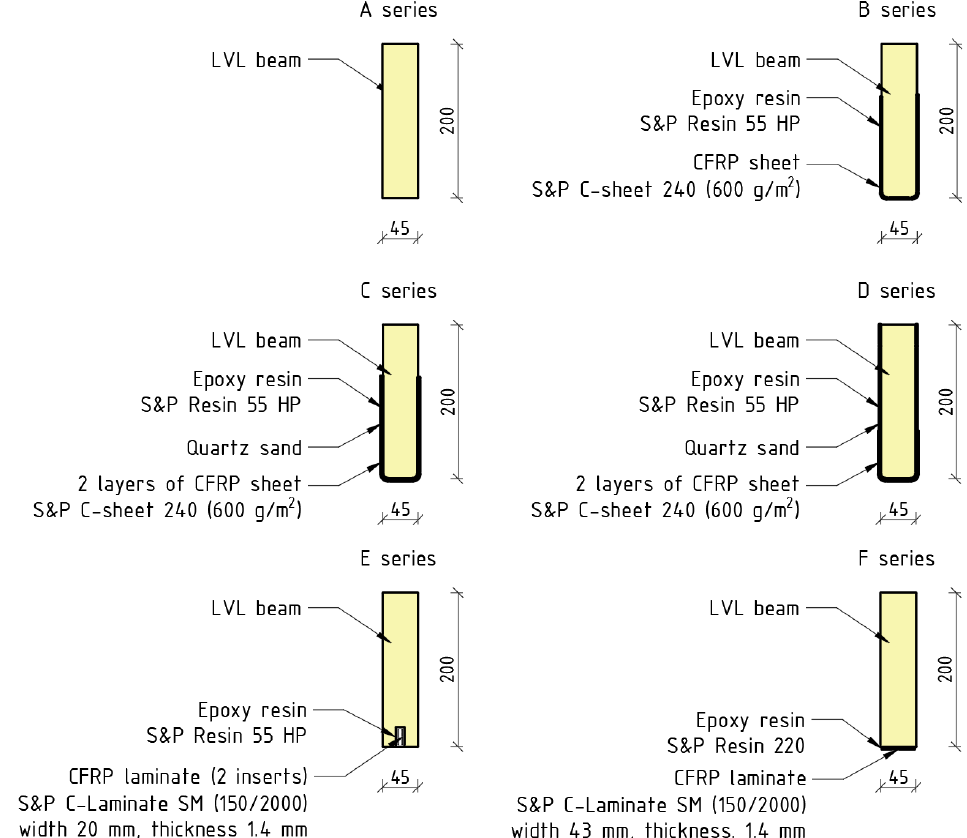
Figure 1. Tested series: unreinforced beam (A series); beam reinforced with one layer of CFRP sheet (B series); beam reinforced with two layers of CFRP sheet bonded in tension zone (C series); beam reinforced with two layers of CFRP sheet covering entire side surface with overlap in tension zone (D series); beam reinforced with two CFRP laminate inserts bonded into pre-drilled grooves (E series); beam strengthen with CFRP laminate bonded to bottom side (F series)